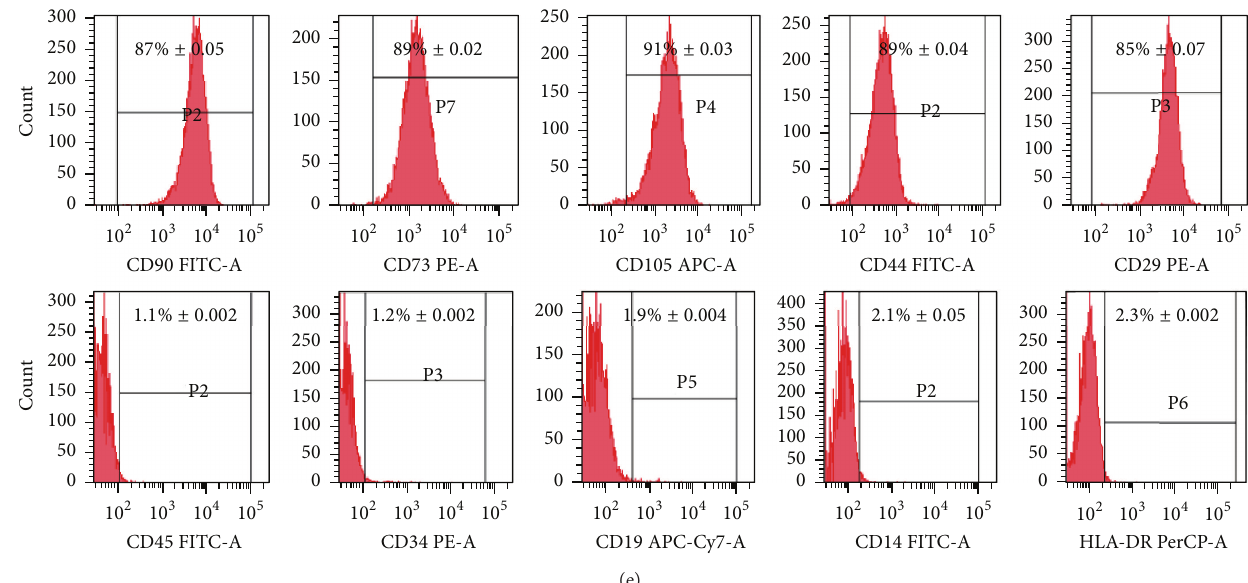
Figure 1: Characterization of human umbilical cord-derived mesenchymal stem cells. (a) Immunofluorescent staining of HGF protein in the liver of HGF-UCMSC treated mice. No HGF was detected in livers from the control group. Cells were HGF-positive (red) two days after HGF adenovirus infection at MOI 50. (b) Western blot of HGF in the liver of treated mice. Ad-UCMSCs: UCMSCs transfected with adenovirus carrying the control vector. (c) Differentiation of human umbilical cord-derived mesenchymal stem cells. Osteogenic differentiation was detected by calcium deposits stained by Alizarin Red. Adipogenic differentiation was detected by oil red O staining (400 × ). Morphology of UCMSCs and HGF-UCMSCs at day 10 of culture (40x). (d-e) Mesenchymal stem cell marker profile of the parent UCMSCs and HGF- UCMSCs. The data are representative of three independent